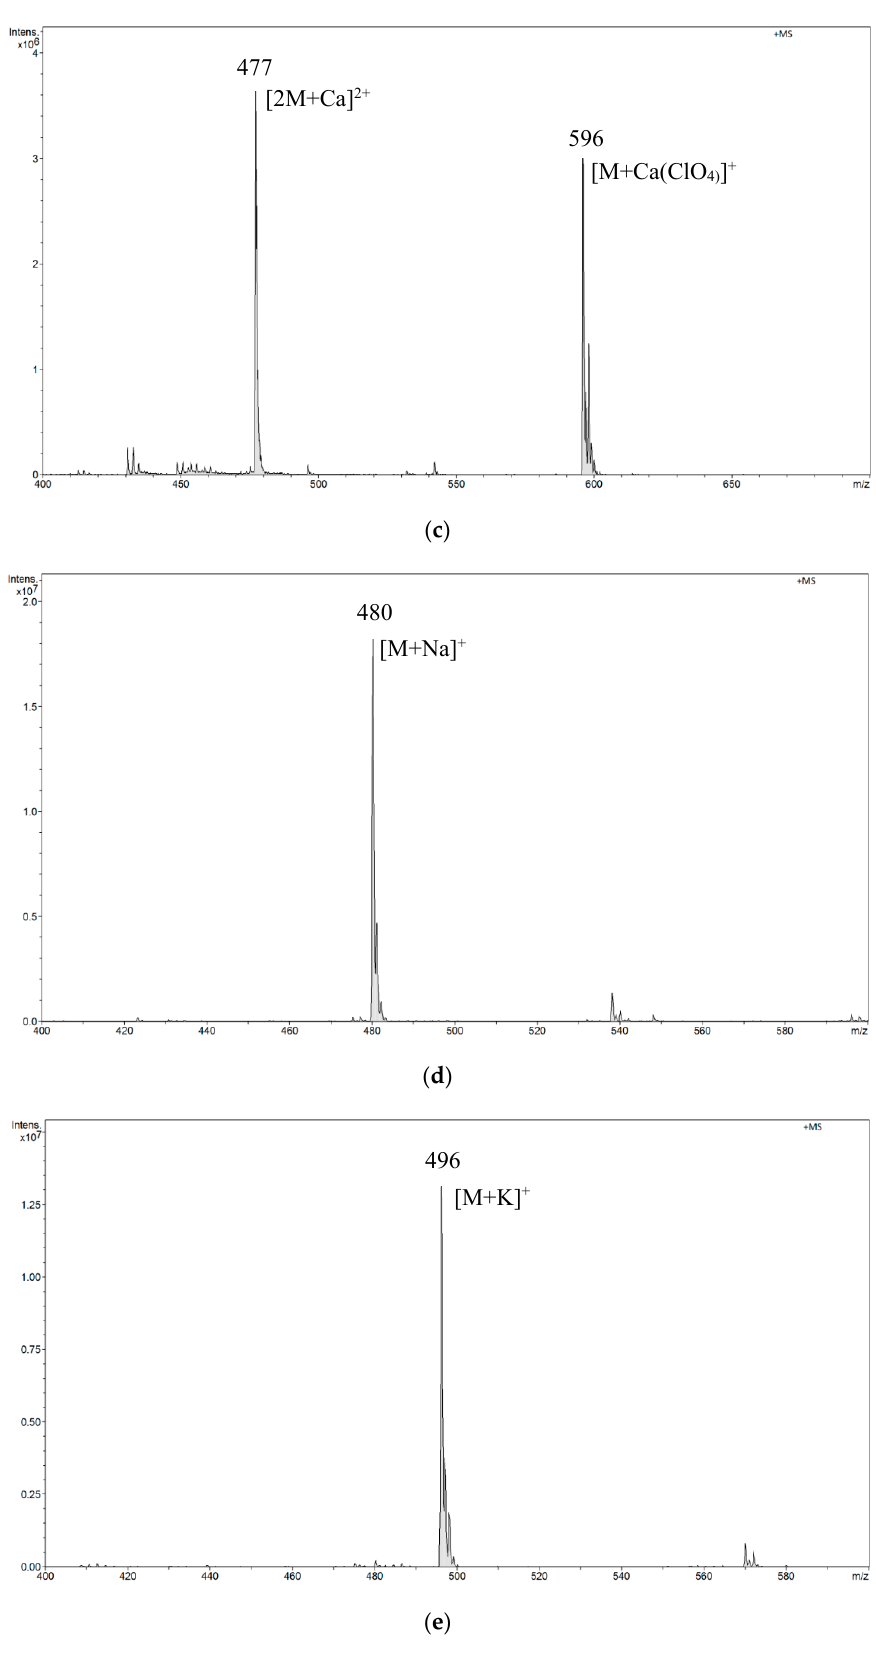
Figure 7. The ESI-MS spectrum of amygdalin performed in solutions with the addition of various ions: ( a ) Cu 2 + , ( b ) Pb 2 + , ( c ) Ca 2 + , ( d ) Na + , ( e ) K +